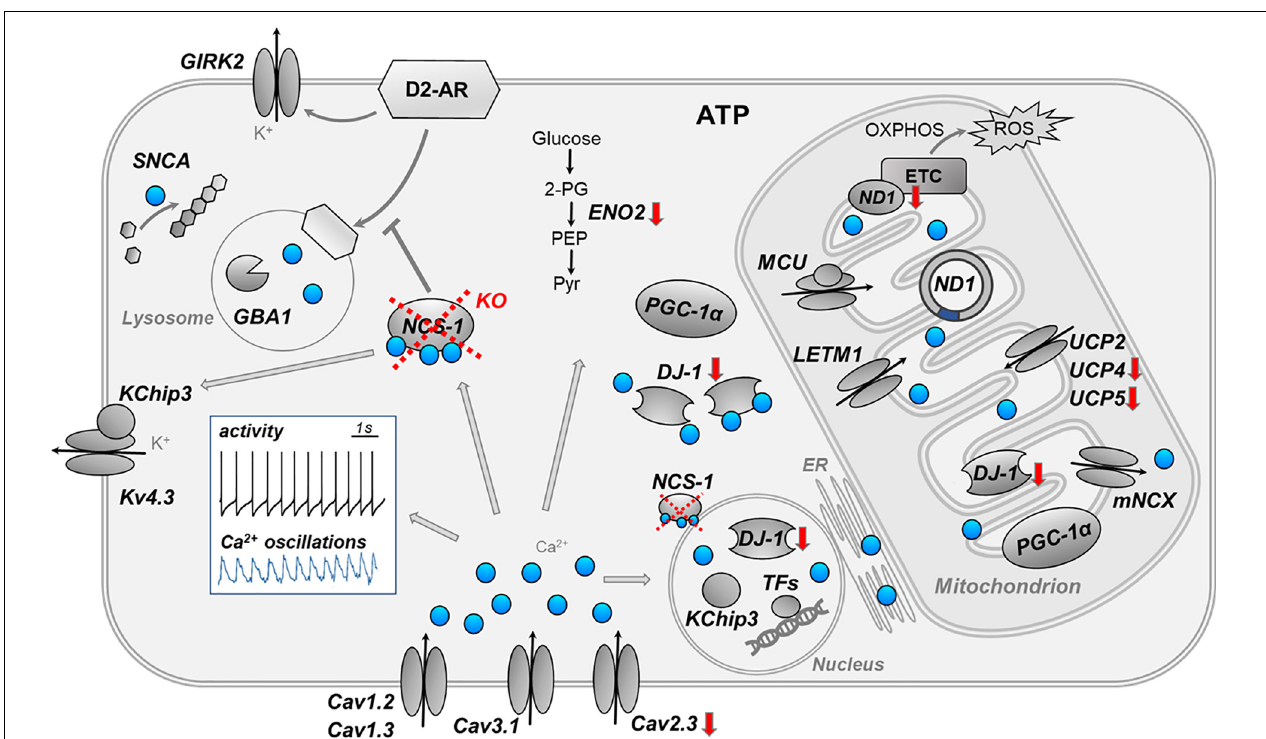
FIGURE 6 | Summary cartoon of detected gene expression changes in SN DA neuron from NCS-1 KO mice. The cartoon summarizes the main findings and conclusions of this study and illustrates the complex activity- and compartment-dependent roles of Ca 2 + signaling in vulnerable SN DA neurons. The white insert-box illustrates the autonomous pacemaker activity (black trace) and the associated Ca 2 + transients (blue trace) of SN DA neurons (perforated patch clamp and Calcium-imaging experiment, adapted from Liss and Striessnig (2019). Loss of NCS-1 is indicated by red cross, red arrows indicate transcriptional changes in NCS-1 KO mice. Ca 2 + (blue dots) has a variety of different physiological and potentially detrimental functions in distinct compartments of SN DA neurons, like stimulating ATP synthesis enzymes, controlling gene expression, and triggering apoptosis. Ca 2 + can indirectly inhibit electrical activity of SN DA neurons by stimulating NCS-1/D2-AR or Kv4.3/KChip3 activity. Similar as NCS-1, KChip3 (also known as DREAM or Calsenilin) is not only a β -subunit of voltage-gated Kv4.3 K + channels, but it can also translocate from the plasma-membrane to the nucleus, where it controls Ca 2 + dependent enzymes or gene expression. For further details, see text. ATP, adenosine triphosphate; Cav, voltage-gated Ca 2 + channel; DJ-1, protein deglycase; D2-AR, dopamine D2 autoreceptor; ENO2, neuron specific enolase; ER, endoplasmic reticulum; ETC, electron transfer chain; GBA1, glucocerebrosidase 1; GIRK2, G protein-coupled inwardly rectifying potassium channel; KChip3, Calsenilin (also known as DREAM); KO, knockout; Kv4.3, voltage-gated potassium channel subfamily D member; LETM1, leucine zipper EF-hand containing transmembrane protein 1; MCU, mitochondrial Ca 2 + uniporter (pore-forming subunit); mNCX, mitochondrial sodium-calcium exchanger; NCS-1, neuronal calcium sensor 1; ND1, NADH-ubiquinone oxidoreductase chain 1; OXPHOS, oxidative phosphorylation; PEP, phosphoenolpyruvate; PGC-1 α , peroxisome proliferator-activated receptor gamma coactivator 1-alpha; Pyr, pyruvate; ROS, reactive oxygen species; SNCA, alpha-synuclein gene; TFs, transcription factors; UCP, uncoupling protein; 2-PG,